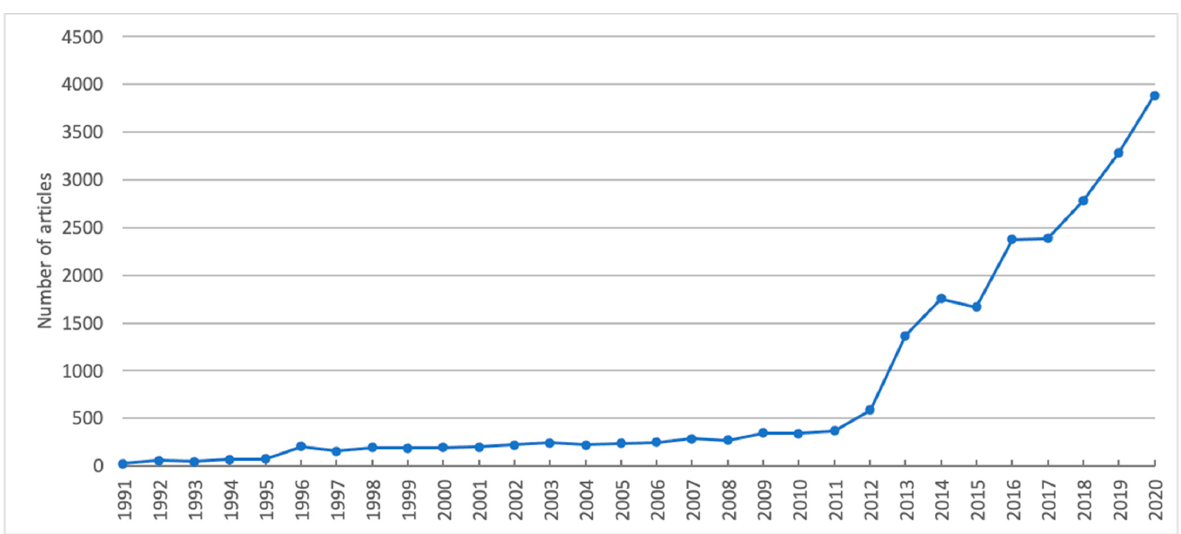
Figure 1. Research publication trend of Kazakhstan during 1991–2020.